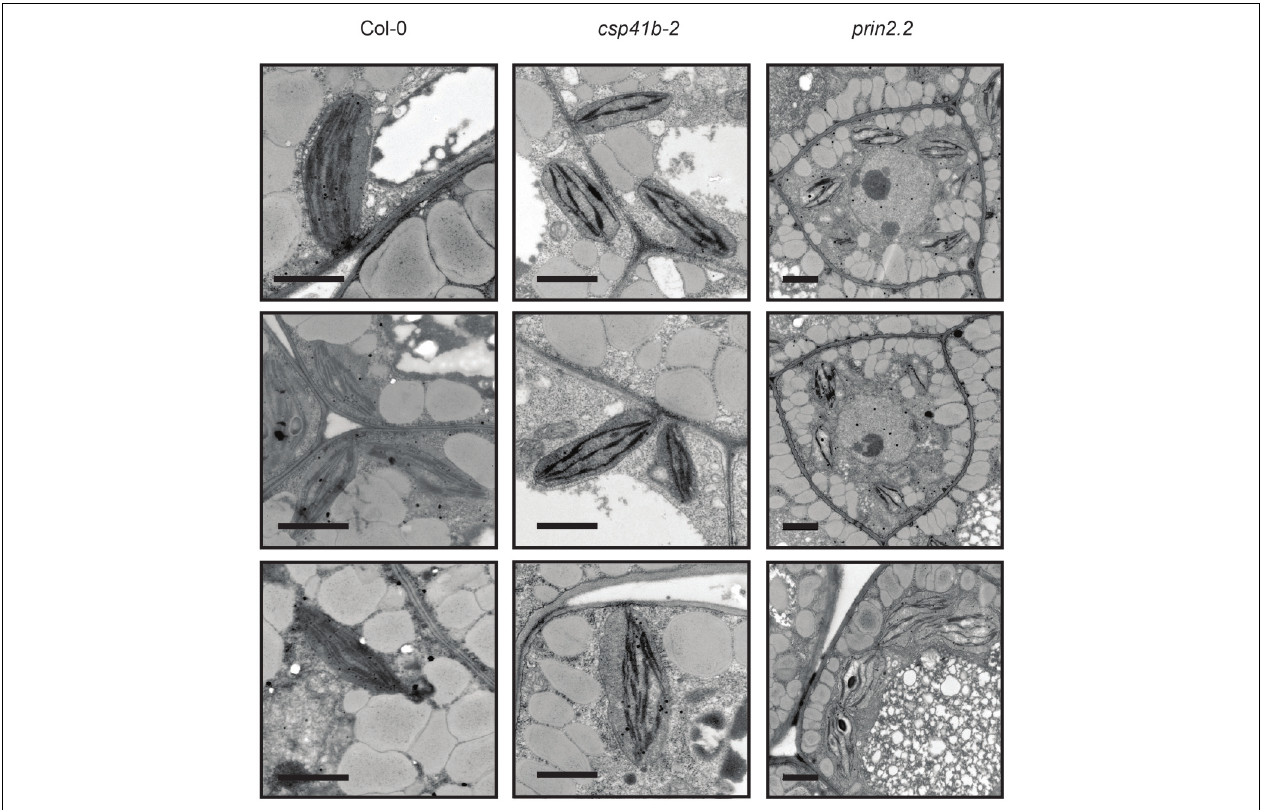
FIGURE 4 |The csp41b-2 and 2prin2.2 mutants display impaired chloroplast during embryo development. RepresentativeTEM images of chloroplasts from the Col-0, csp41b-2, and prin2.2 mature green (MG) embryos. Bars represent 1 μ m.